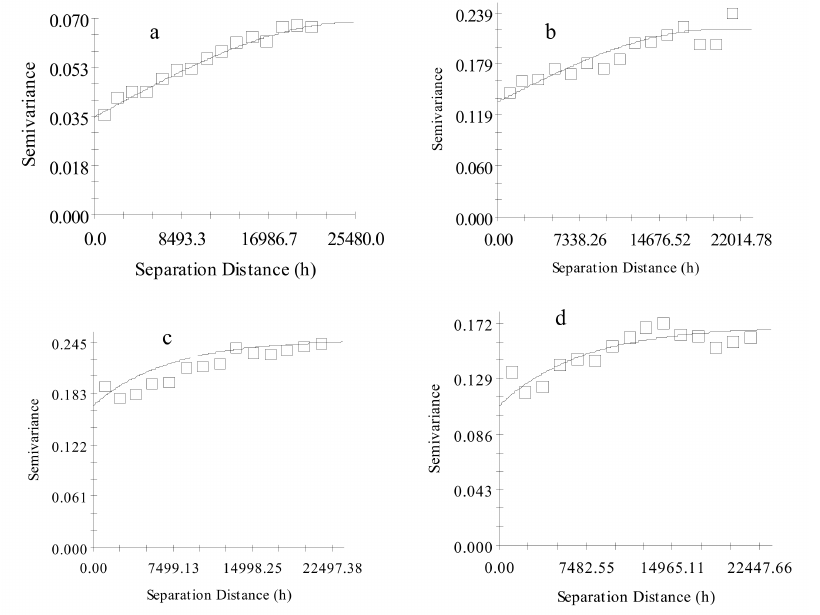
Figure 7. Semi-variograms of soil salinity at 20 depths in typical years. ( a ) Semi-variogram of soil salinity 2006; ( b ) Semi-variogram of soil salinity 2012; ( c ) Semi-variogram of soil salinity 2013; ( d ) Semi-variogram of soil salinity